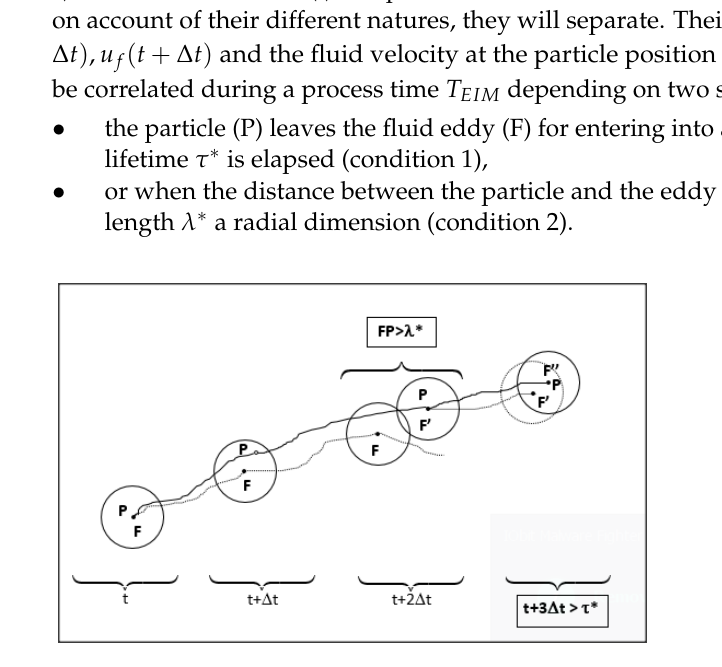
Figure 1. Sketch of the eddy interaction model. The time step T EIM of the Monte-Carlo process will be, if condition 1 is verified, the eddy lifetime τ ∗ or, if condition 2 is respected, the transit time τ R taken by the inertial particle to cover a distance larger than the eddy length λ ∗ , that is, (cid:107) X p ( t ) − X f ( t ) (cid:107) > λ ∗ . The Monte-Carlo time is given by T EIM = min ( τ ∗ , τ R ) . Thus the eddy–particle interaction time is limited by the eddy lifetime or the transit time needed for the particle to cross the eddy. The eddy lifetime τ ∗ is related to a Lagrangian integral time scale T L or to a spectrum of the fluid turbulent flow, the eddy length λ ∗ to an Eulerian length scale L E of the turbulence. This kind of model should at least simulate part of the crossing-trajectory effects (CTEs), and, if possible, the inertia effects by solving the equation of motion with a time step ∆ t << T EIM . In the literature, the EIMs differ in the way the different time scales T L , τ ∗ , ∆ t or length scales L E , λ ∗ are chosen. In these stochastic trajectory models, the random fluid elements interacting with a particle have a length and time scales , λ ∗ , τ ∗ , and the fluid velocities can be generated with constant ∆ t or random time steps δ t i . The velocity correlation functions are dependent on the choice of the type of time step probability density function f ( δ t i ) as discussed by Wang and Stock [60]. In some cases, the Monte- Carlo process uses exponential distributions for the random eddy lifetime and size, with mean values equal to the Lagrangian integral time scale T L and to the Eulerian transverse length scale L E